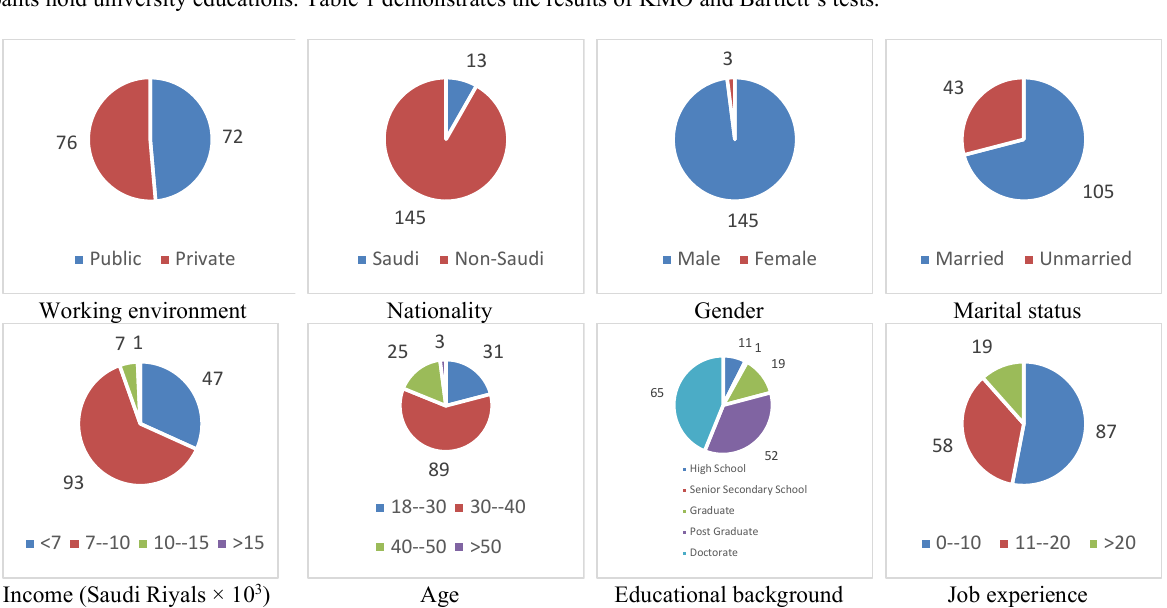
Fig. 1. Personal characteristics of the